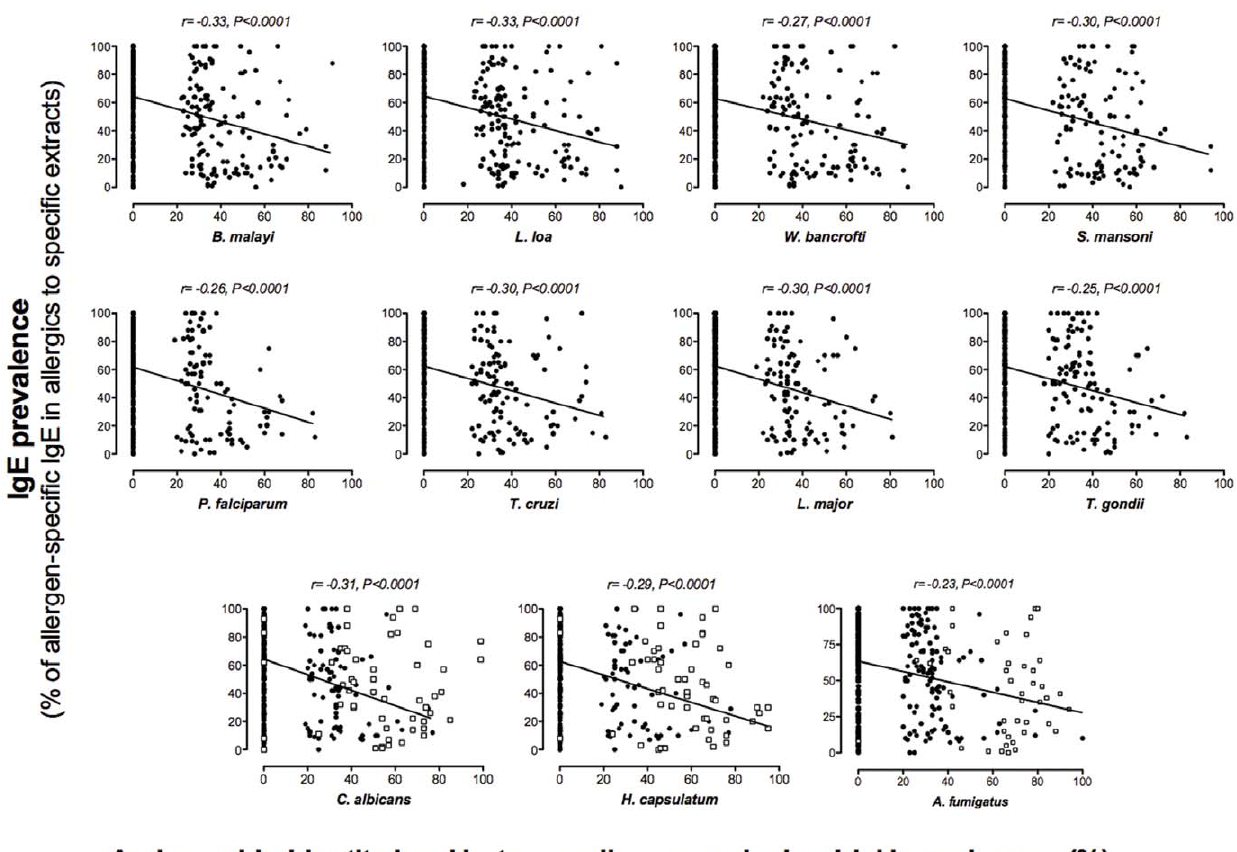
Figure 3. The level of allergenicity inversely correlates with the level of the conservation of the allergen. The IgE prevalence (y-axis) in a specific allergic population was plotted against the identity level (x-axis) between the allergen and its microbial homologue and correlation evaluated by Spearman rank test. Each dot represents one allergen and the lines represent the trend line. Allergens without homologues are stacked in the identity equal to zero area.